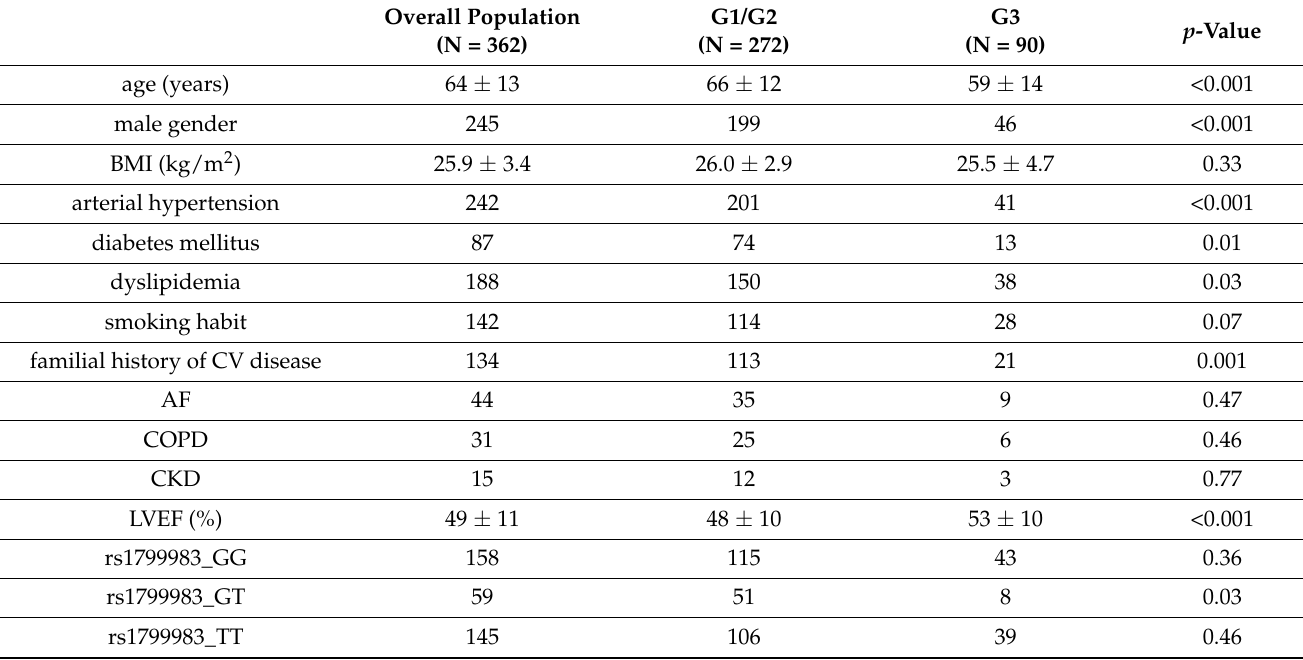
Table 1. Baseline features of the overall population, and differences between the ischemic groups (G1 and G2) and control group (G3).